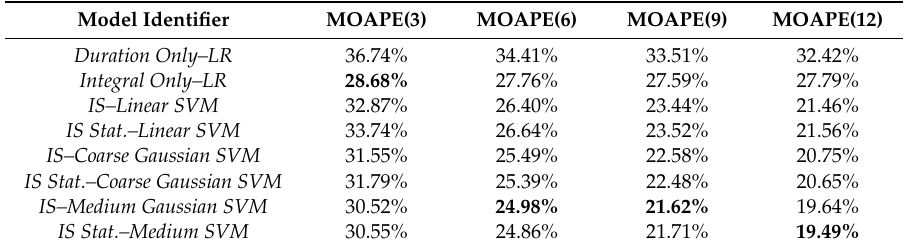
Figure 8. Distribution of volume mean absolute percentage error across trials for the best-case estimator. Table 4. Variation in volume mean overall absolute percentage error for multiple prompt periods (bold values emphasize the best performing model for each period).